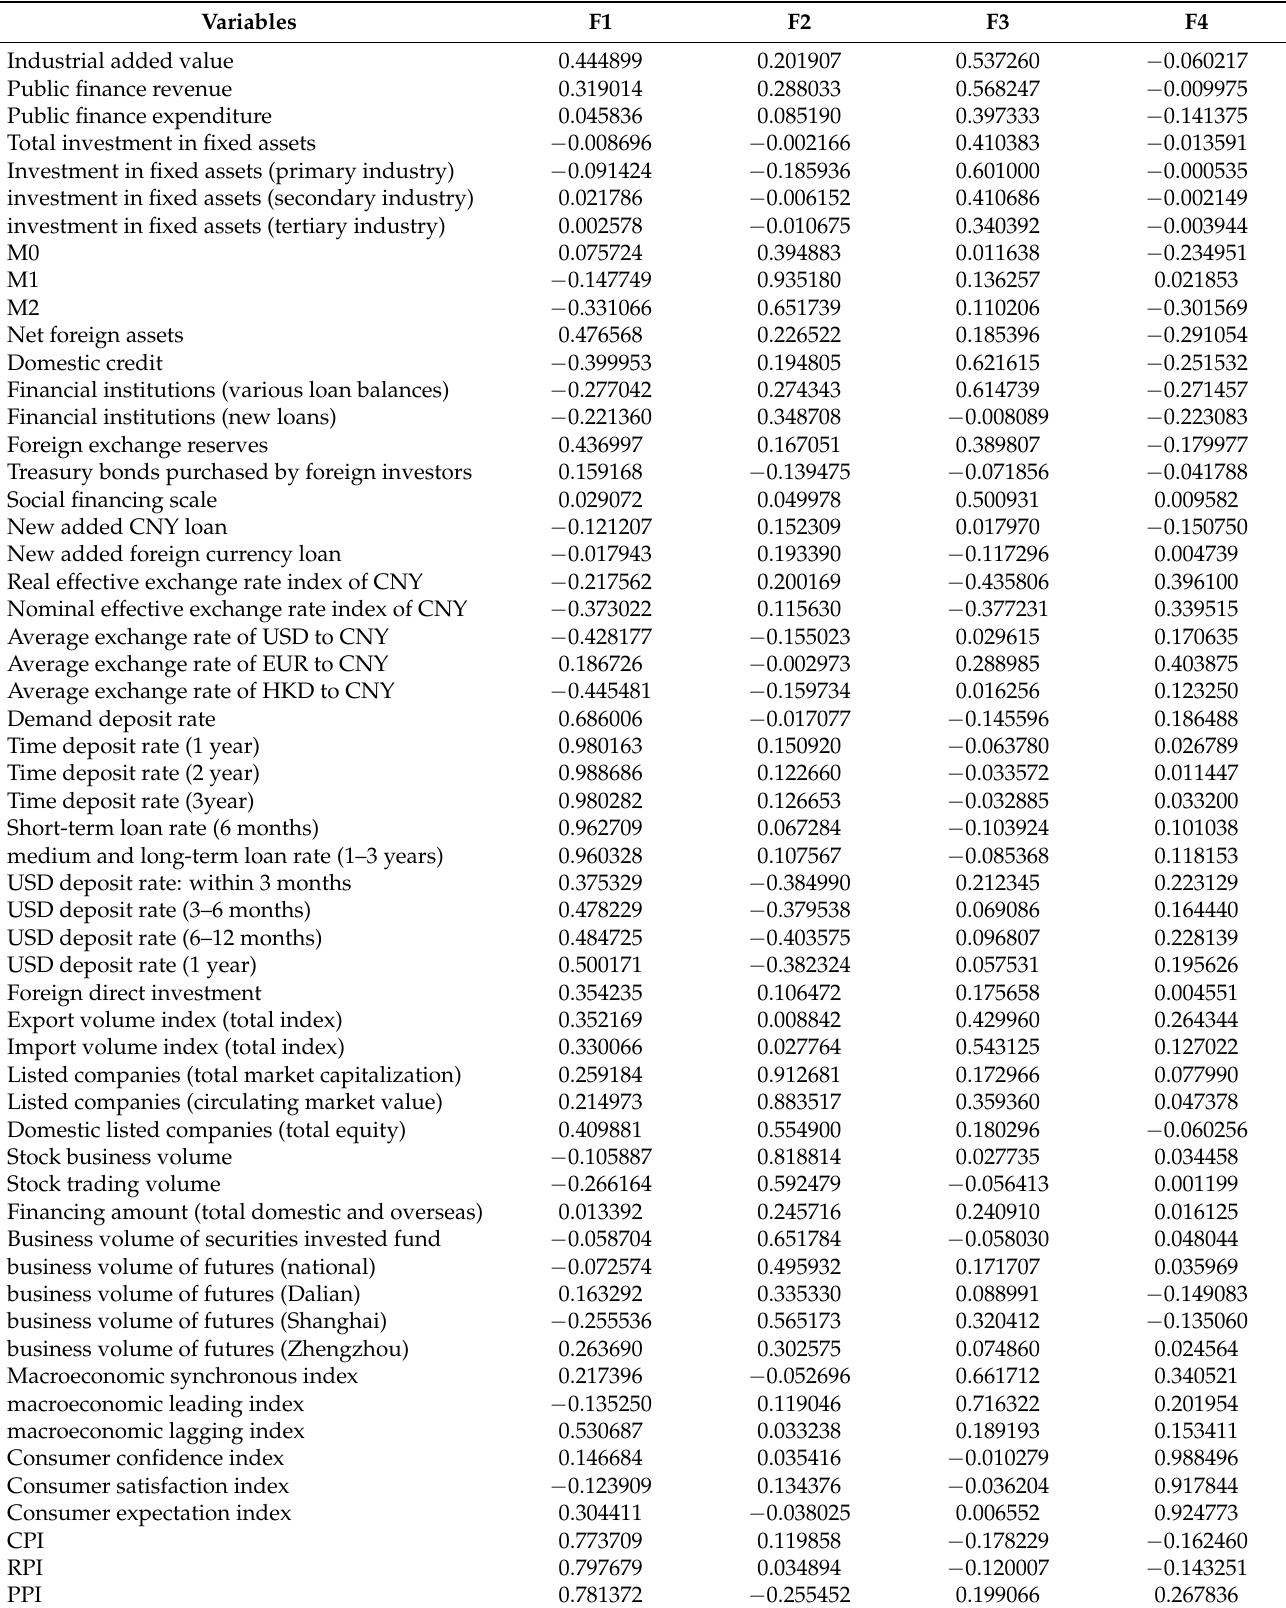
Table A2. Factor analysis results of economic uncertainties after